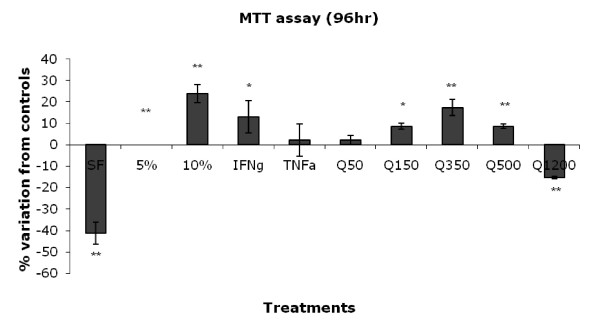
Proliferation measurement after stimulation with QUIN for 96 hours, SF = serum free, 5% FCS = normal control and 10% FCS = positive control. Statistical values of P < 0.05 = *, P < 0.01 = ** and P < 0.001 = *** were taken as significant. Proliferation assay was optimized at 96 hours and was done in triplicates. The normal control (5% FCS) was set to 0%.